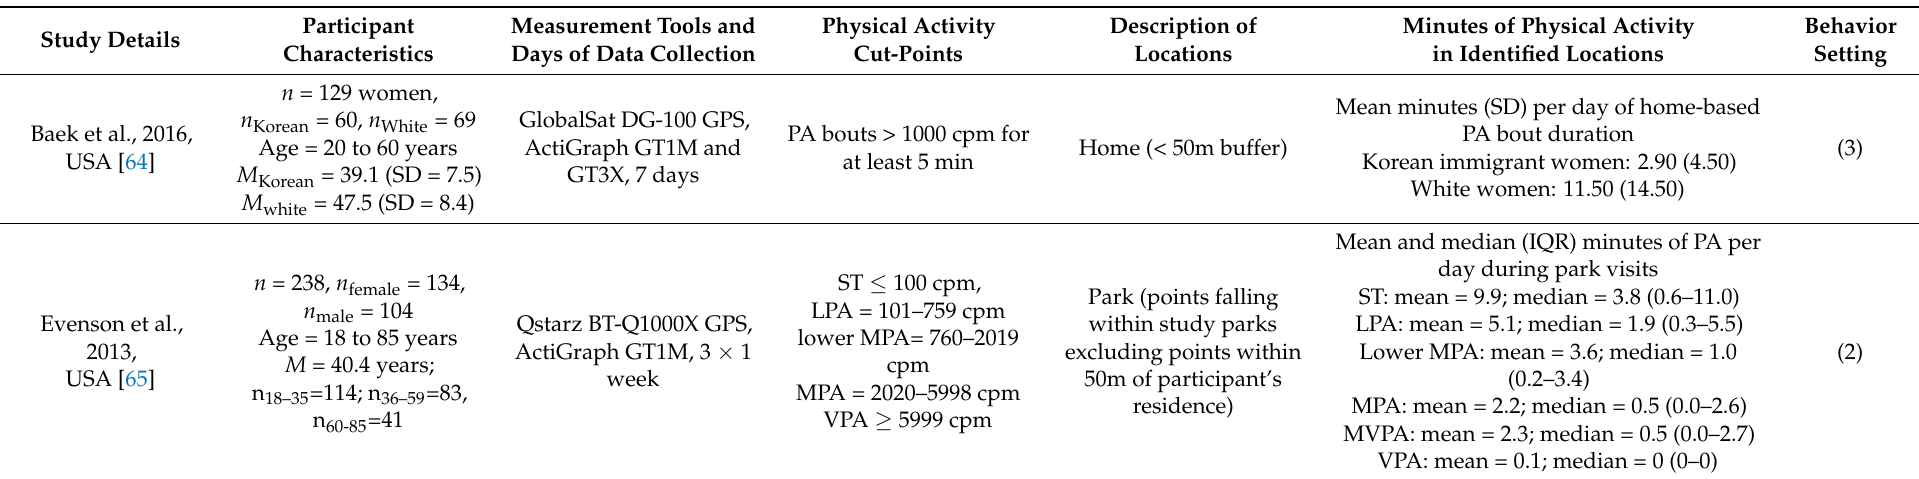
Table 2. Description of included studies targeting adults and summary of main